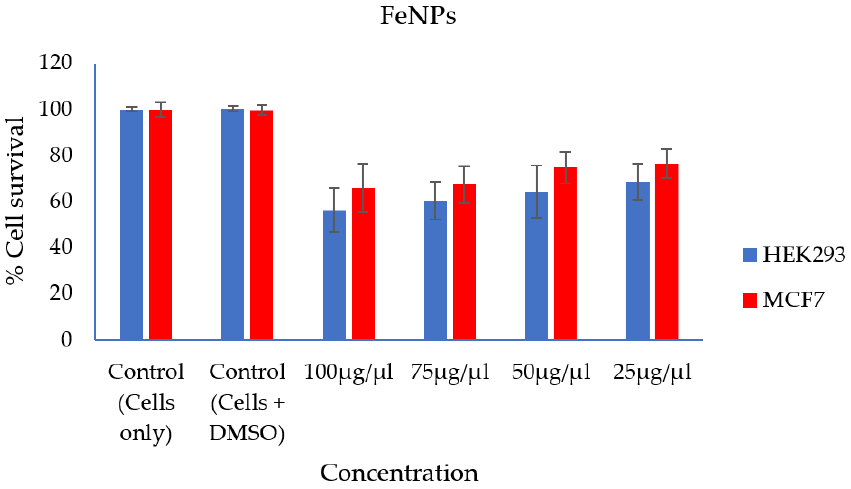
Figure 6. In-vitro cytotoxicity effect of FeNPs nanoparticles on HEK293 and MCF7 cells.